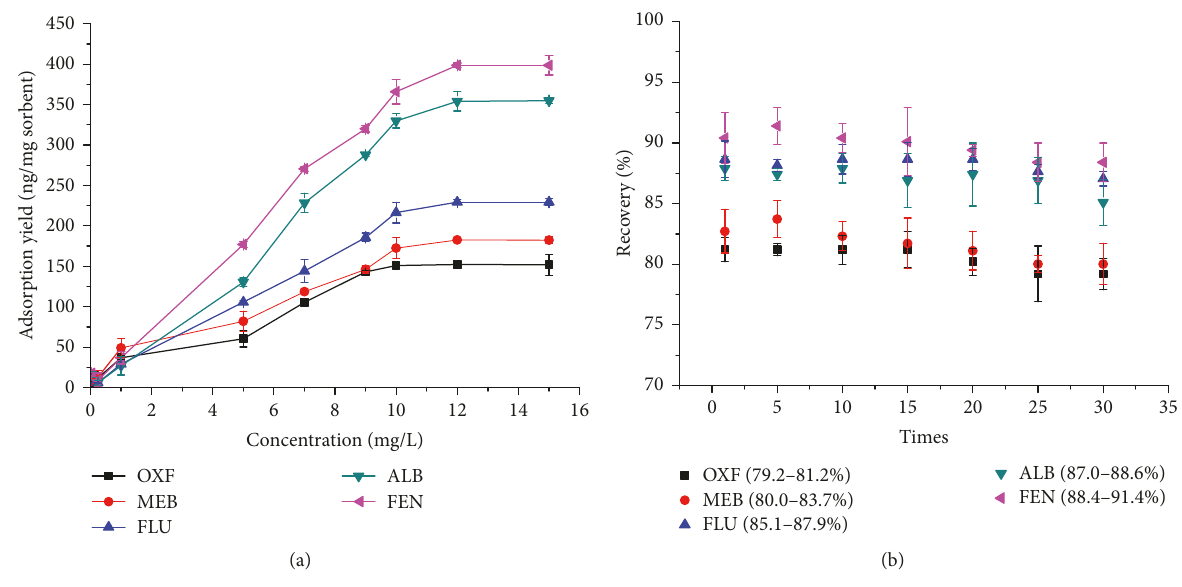
Figure 5: (a) Adsorption capacity of G-Fe 3 O 4 and (b) reusability of G-Fe 3 O 4 in the extraction of